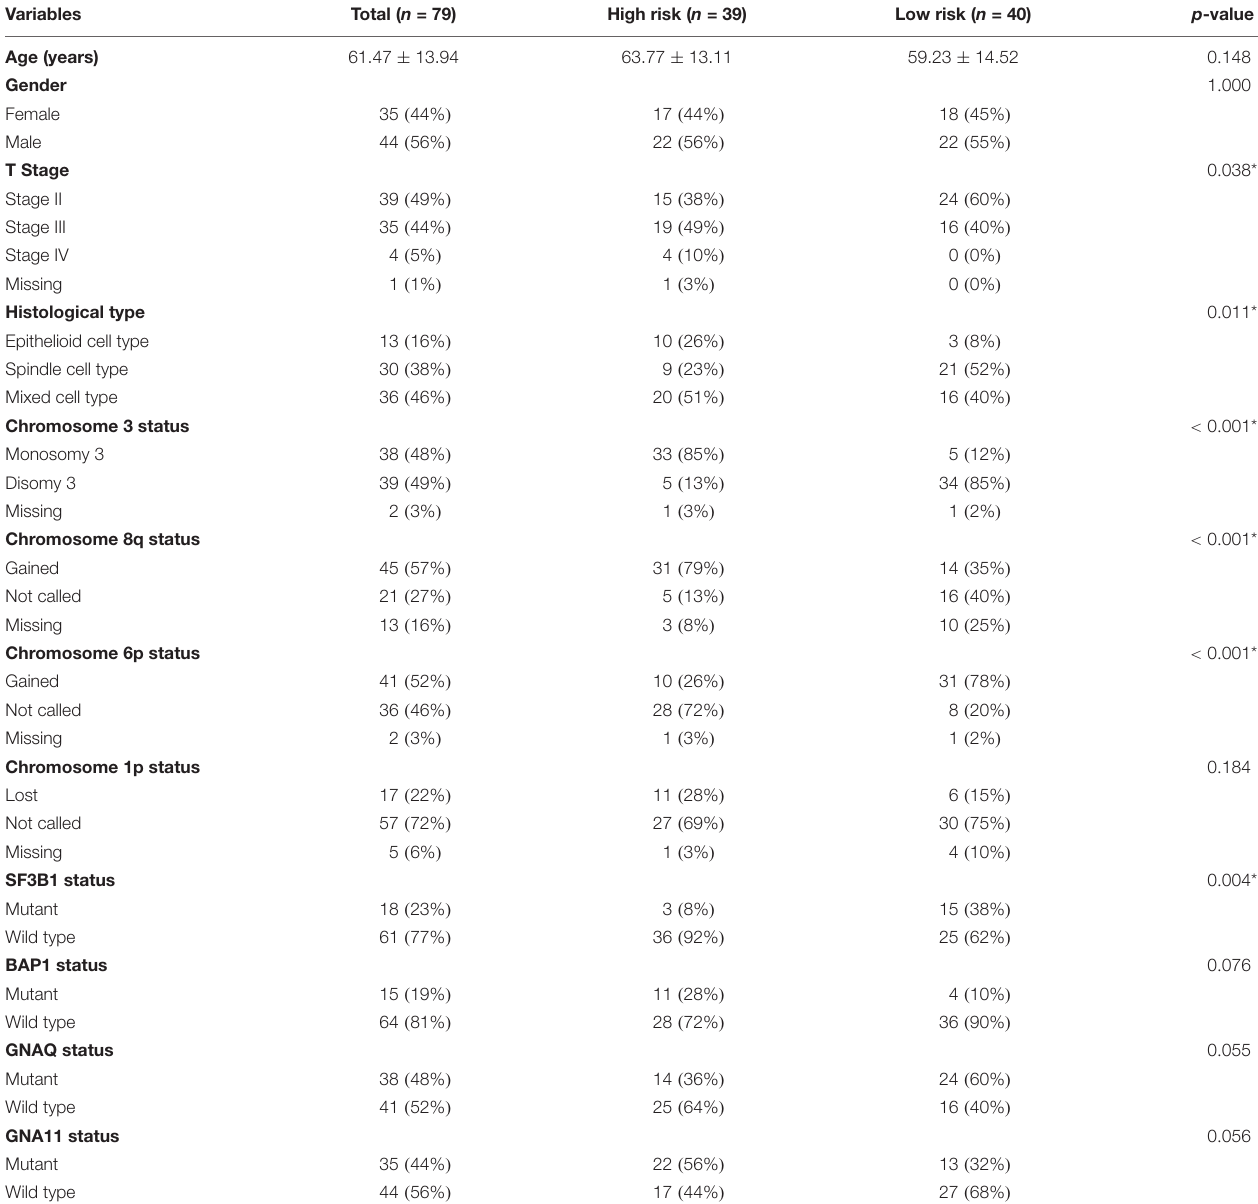
TABLE 2 | Clinical and pathologic characteristics of patients in the high- and low-risk